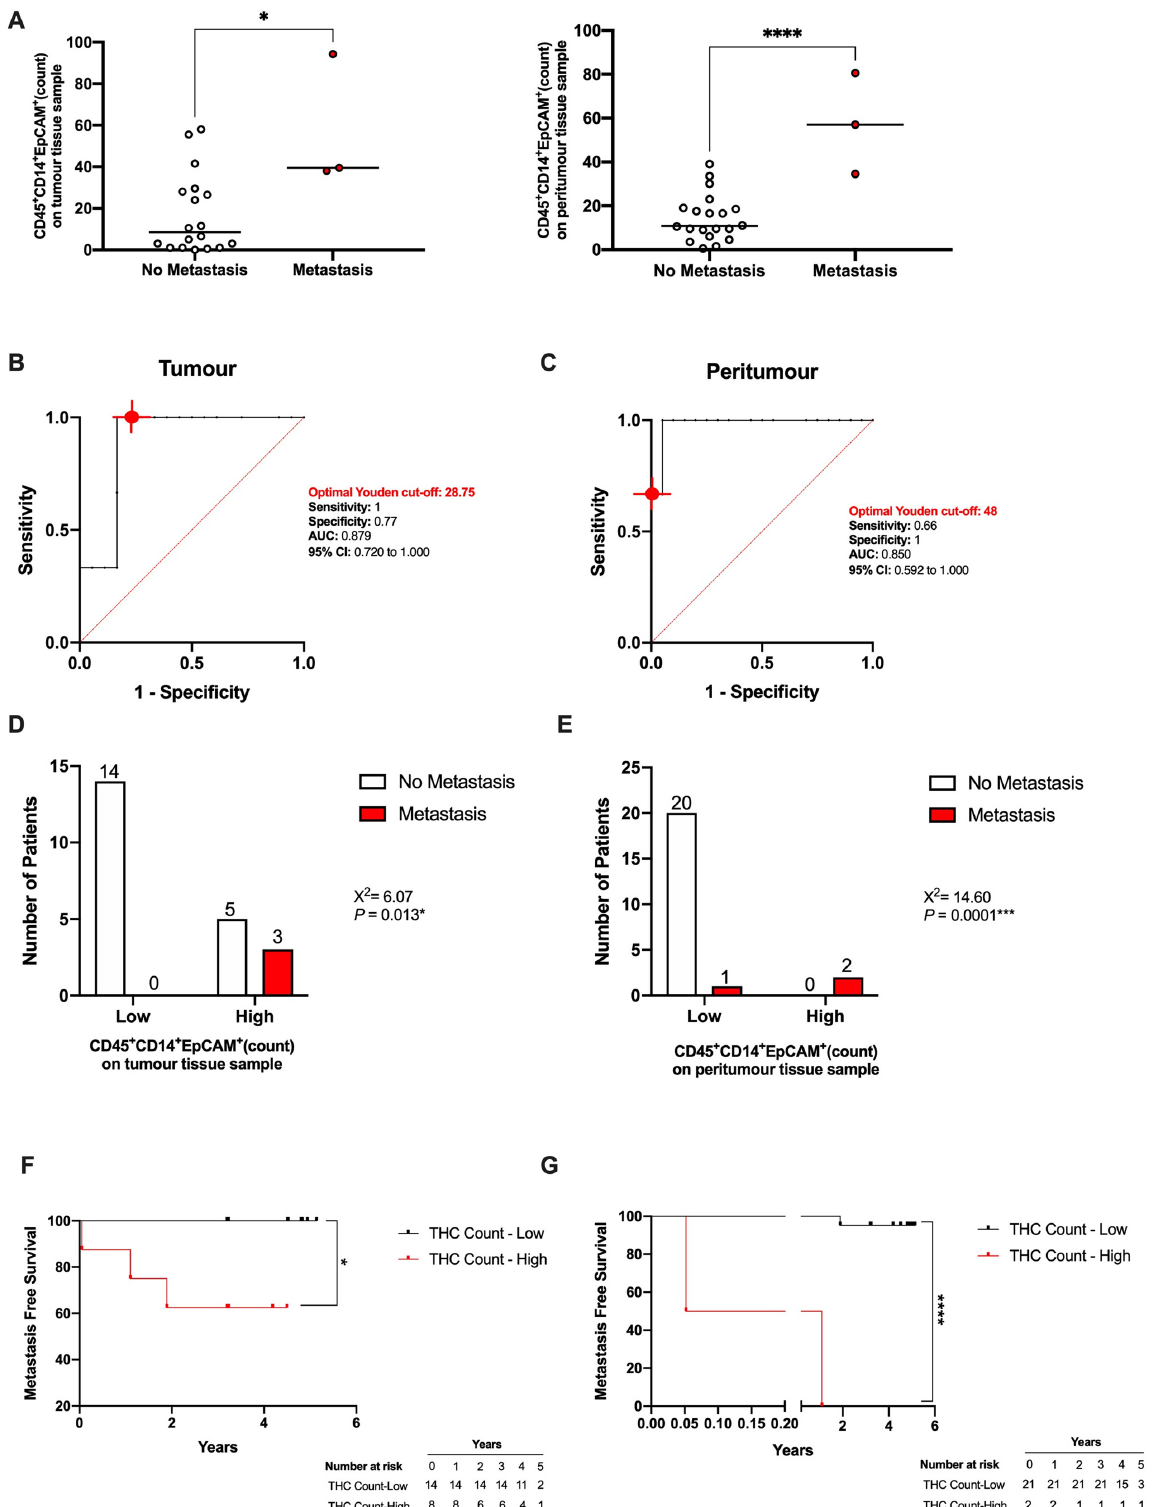
Figure 8. THC counts can serve as a metastasis’ predictor in CRC patients. ( A ) Counts of THCs (CD45 + CD14 + EpCAM + ) on tumour ( left ) and peritumour ( right ) tissue sections of CRC patients with and without metachronous metastases (n = 23). Receiver operating characteristic (ROC) curve describing the predictive performance value of the THC count for metastasis in ( B ) tumour tissue samples (black line; area under the curve [AUC], 0.879 [95% CI 0.720–1.000]) and ( C )